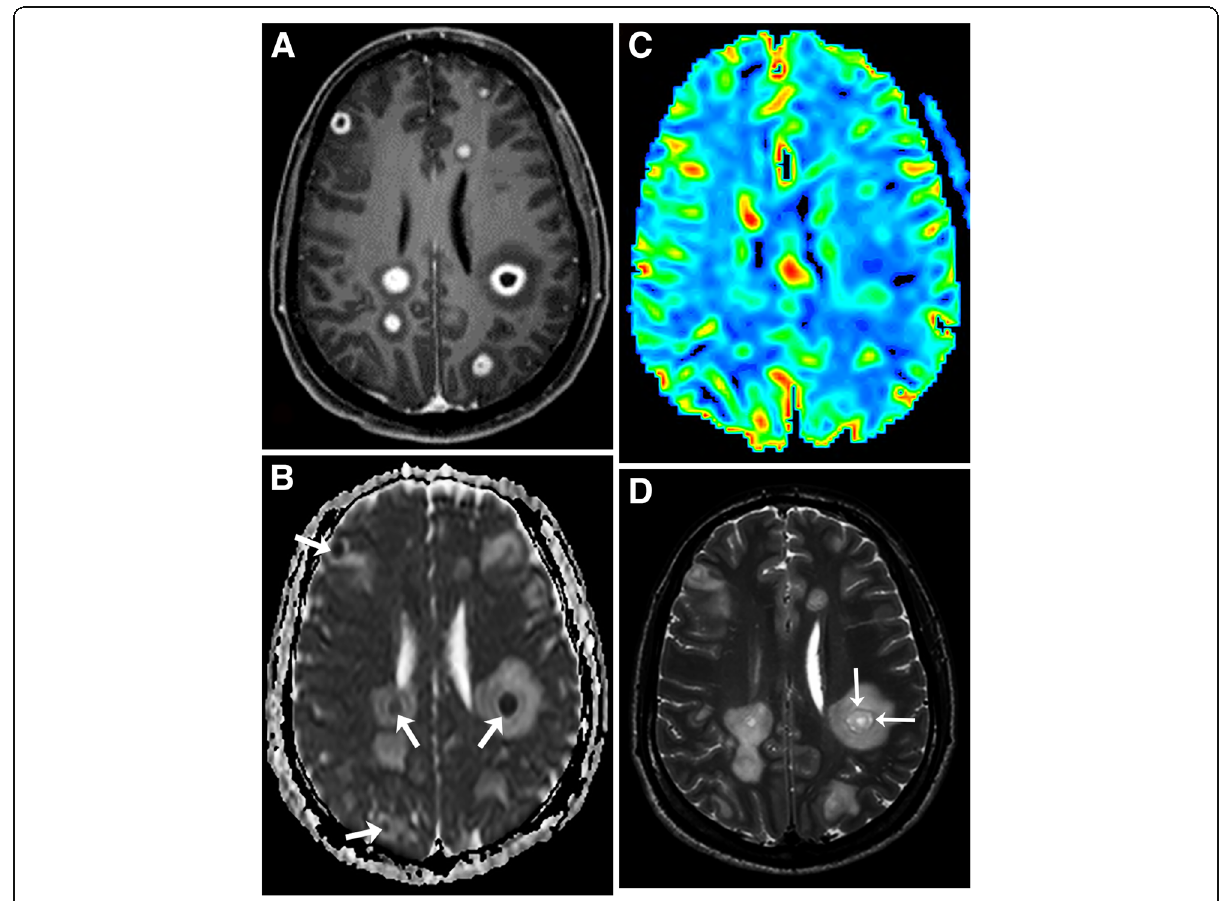
Fig. 9 Streptococcus brain abscesses. T1-weighted image with gadolinium ( a ) demonstrates multiple lesions with rim enhancement and surrounding vasogenic edema. The central core of the lesions restrict strongly (arrows) on the ADC map ( b ). The rims are not restricted. CBV map ( c ) shows mild elevated perfusion in the lesions, but no high perfusion in the surrounding area. Note the T2 hypointense rim (arrows) ( d